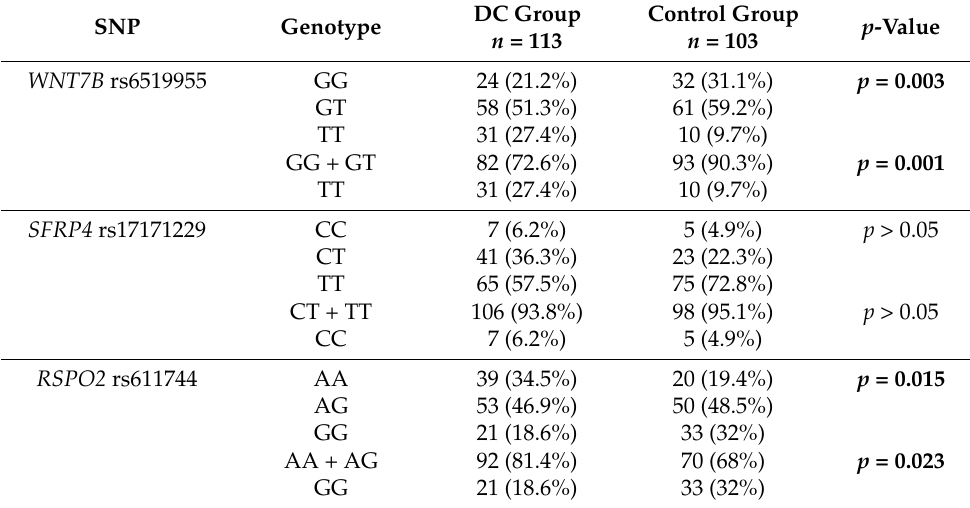
Table 2. Distribution of WNT7B rs6519955, SFRP4 rs17171229 and RSPO2 rs611744 genotypes in DC and control